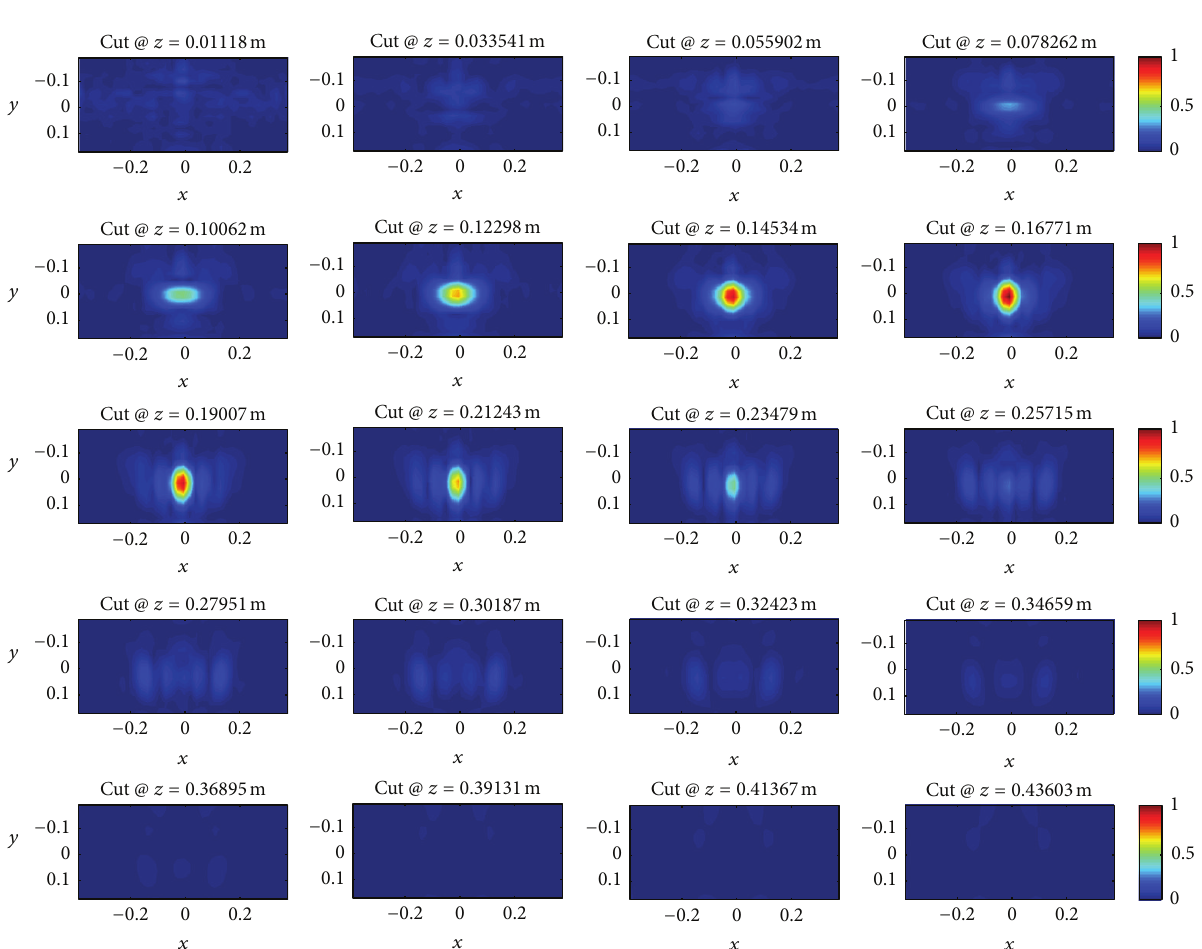
find application in several practical diagnostic